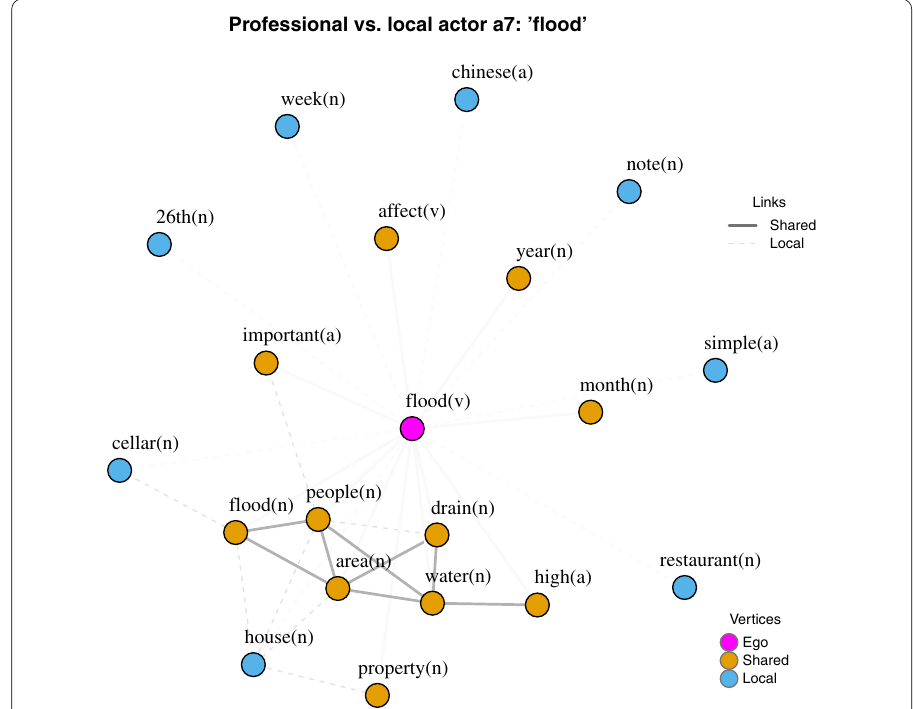
Fig. 12 The usage of the verb “to flood” in the professional and local actor a7 ’s